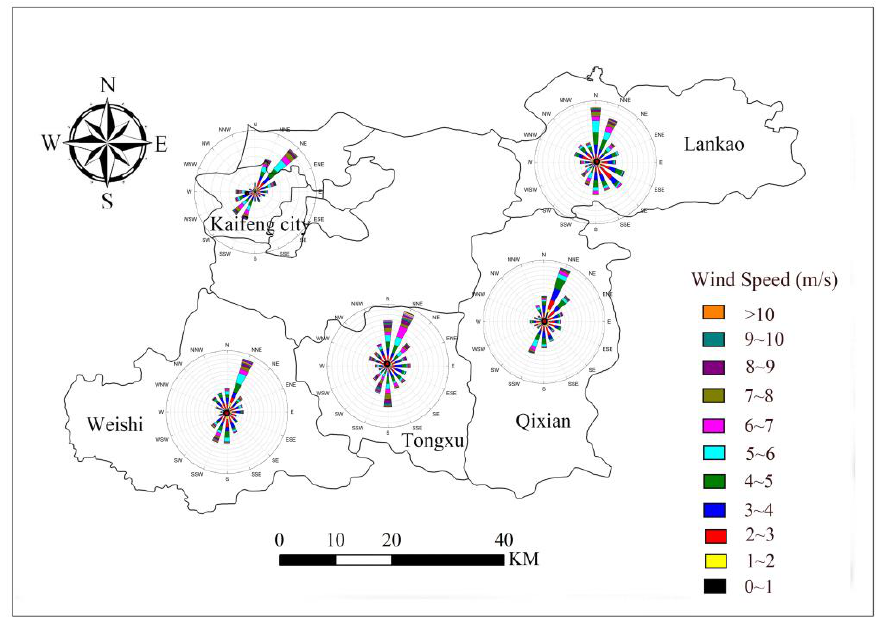
Figure 10. The dominant wind direction in winter (December, January, and February).